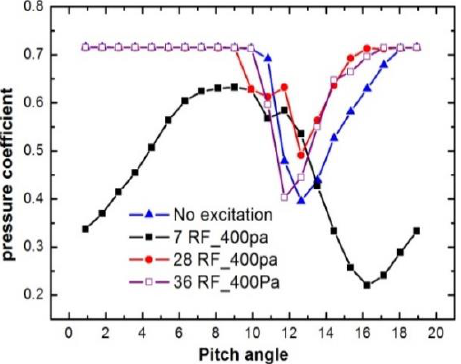
Figure 14. Instantaneous vorticity contour with excitation at 36 times the RF.